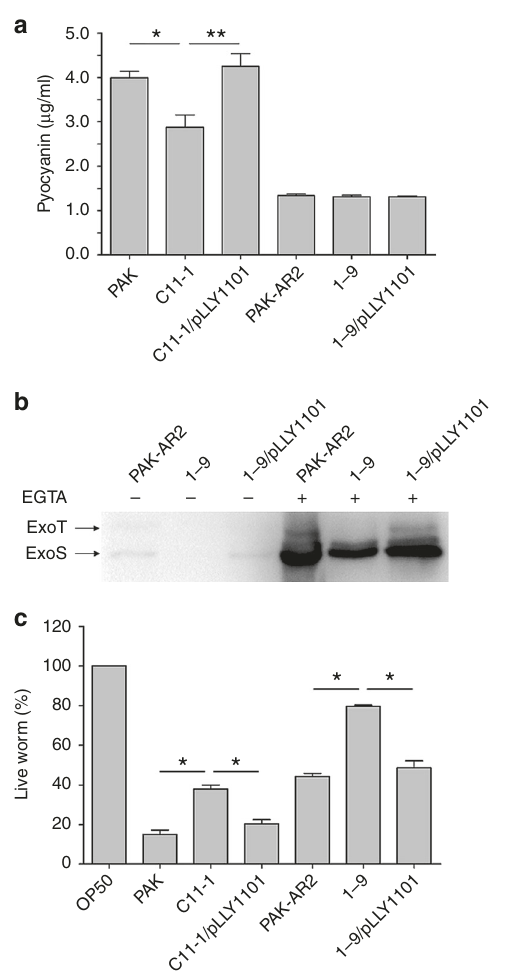
Fig. 6 Virulence assessment of the strain 1 – 9. a Analysis of pyocyanin produced by the indicated P. aeruginosa strains. b Detection of secreted ExoS and ExoT in bacterial culture supernatants by western blot. Full blots are shown in Supplementary Fig. 6. c Worm killing assay. OP50: E. coli strain used for feeding worms. C11-1: a srpA mutant derivative of PAK. 1 – 9: a srpA derivative of PAK-AR2. pLLY1101: a plasmid carrying the srpA gene. Triplicates of each samples were tested. The experiments were independently replicated three times. One-way ANOVA was used to examine the mean differences between the data groups. * P < 0.05. ** P < 0.01. Error bars show standard